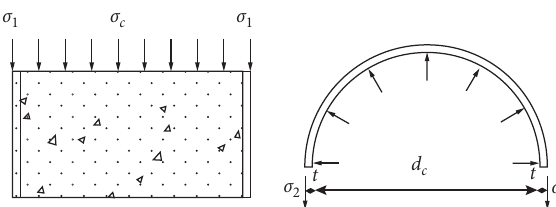
Figure 17: Internal force diagram of turntable